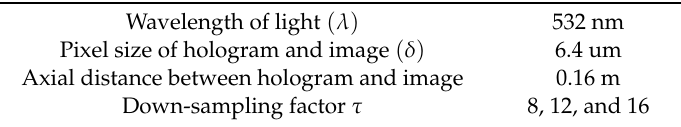
Table 1. Optical settings for generating the Fresnel